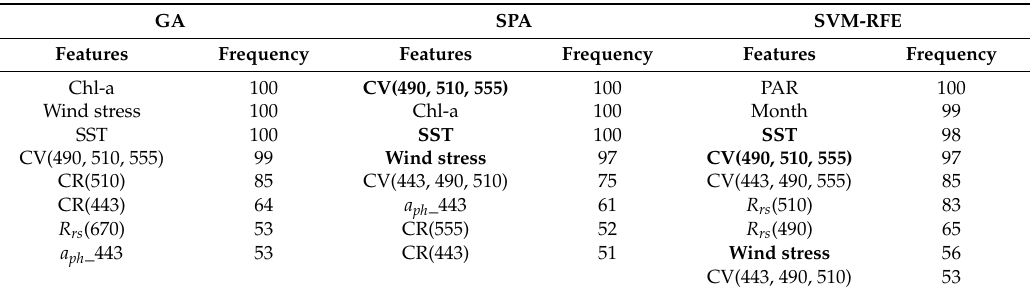
Figure 2. Scatter plots of satellite-derived versus high performance liquid chromatography (HPLC) microplankton size fractions (Fm): ( a ) random forests using features selected with SVM-RFE, ( b ) SVM using features selected with SVM-RFE, ( c ) SVM using ocean color features selected with SVM-RFE, and ( d ) three-component method. The dashed line is a 1:1 line, and the solid line is a regression line. Plot ( e ) shows the frequency distributions of their relative errors, and the numbers along the color ramp indicates the pixel density after log transformation (y = ln(x)). Table 3. Sensitive features for retrieving microphytoplankton size fractions selected, respectively, by genetic algorithm (GA), successive projection algorithm (SPM) and recursive feature elimination based on support vector machine regression